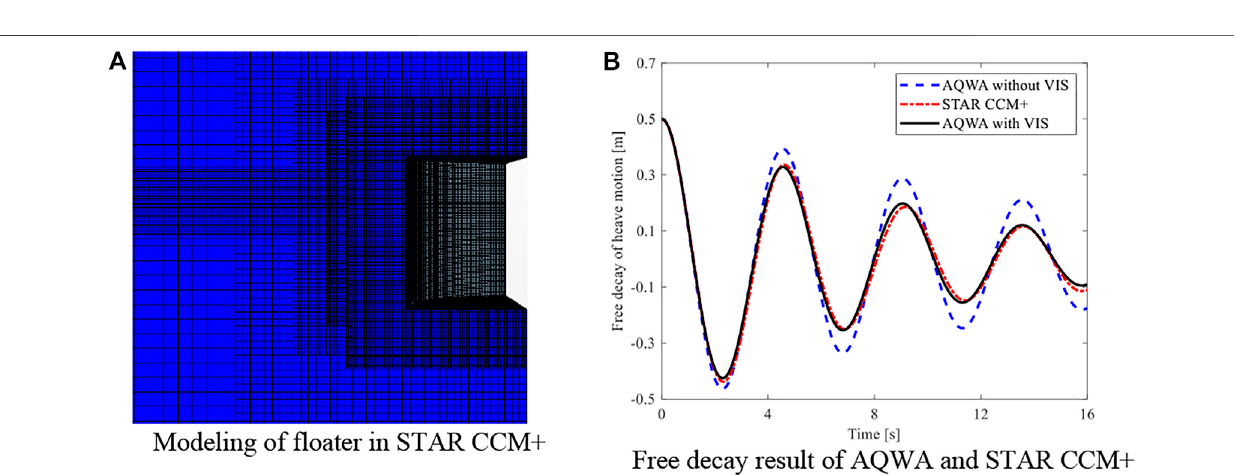
Frontiers in Energy Research |